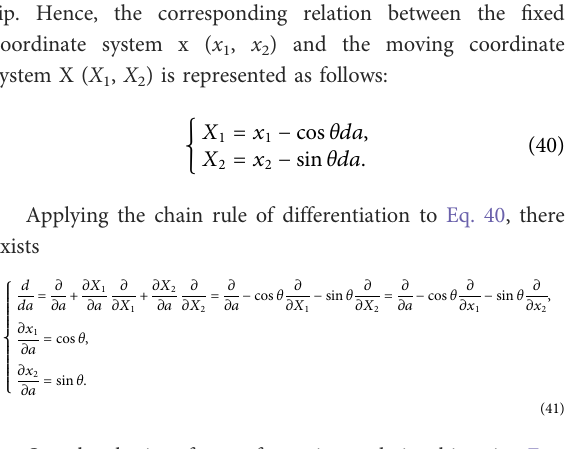
FIGURE 5 Equivalent domain for calculating the energy release rate (i.e., J